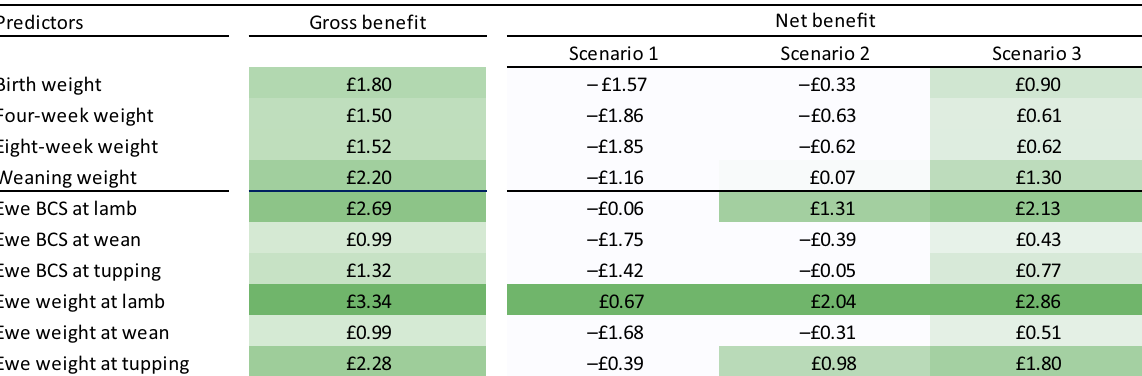
Table 5. Net information values of individual predictors based on realised carcass value. Darker shades indicate higher information values.